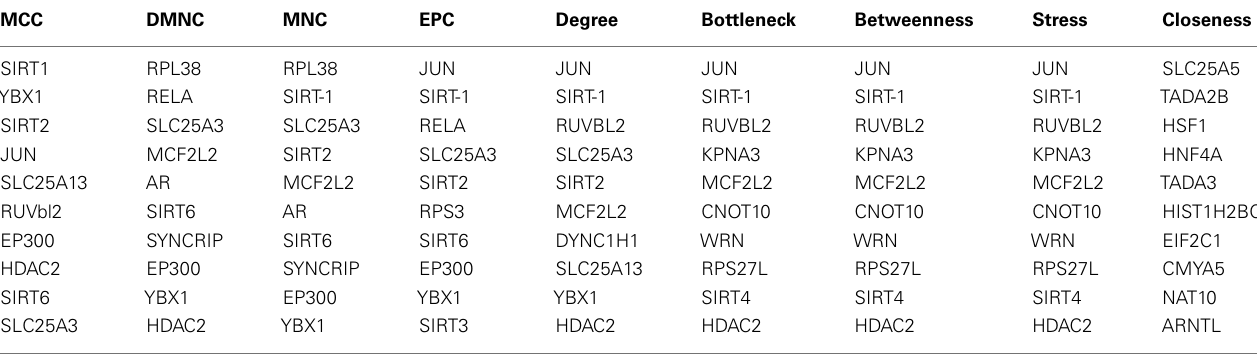
AR, androgen receptor; CMYA, cardiomyopathy associated 5; CNOT10, CCR4-not transcription complex subunit 10; DMNC, density of maximum neighborhood com-